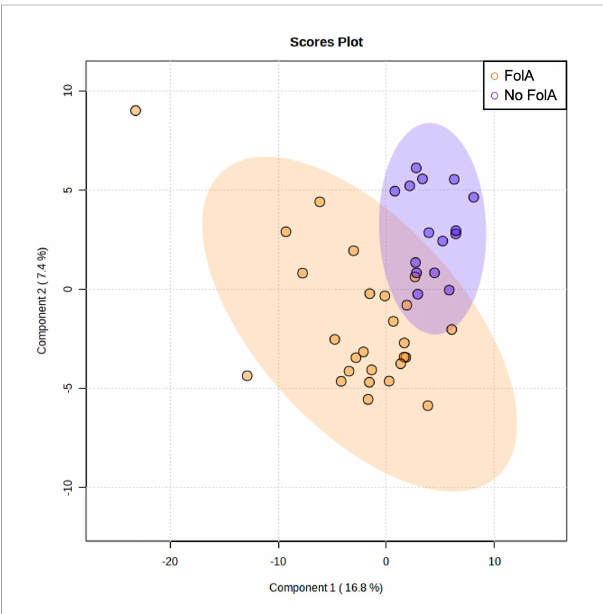
FIGURE 5 Multivariate Partial Least Squares Discriminant Analysis scores plot from women supplemented with folic acid (FolA) and women with no